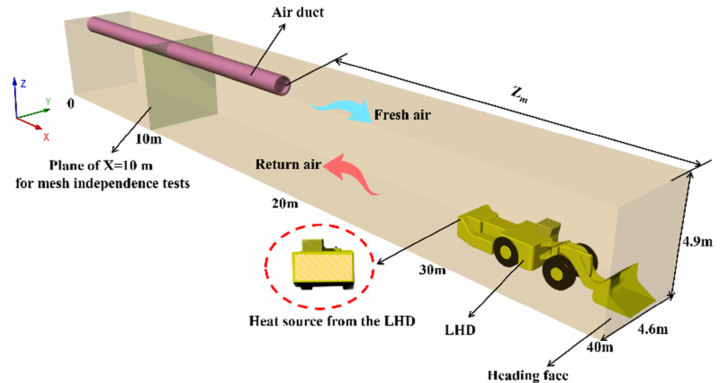
Figure 2. Numerical models of the mucking activities